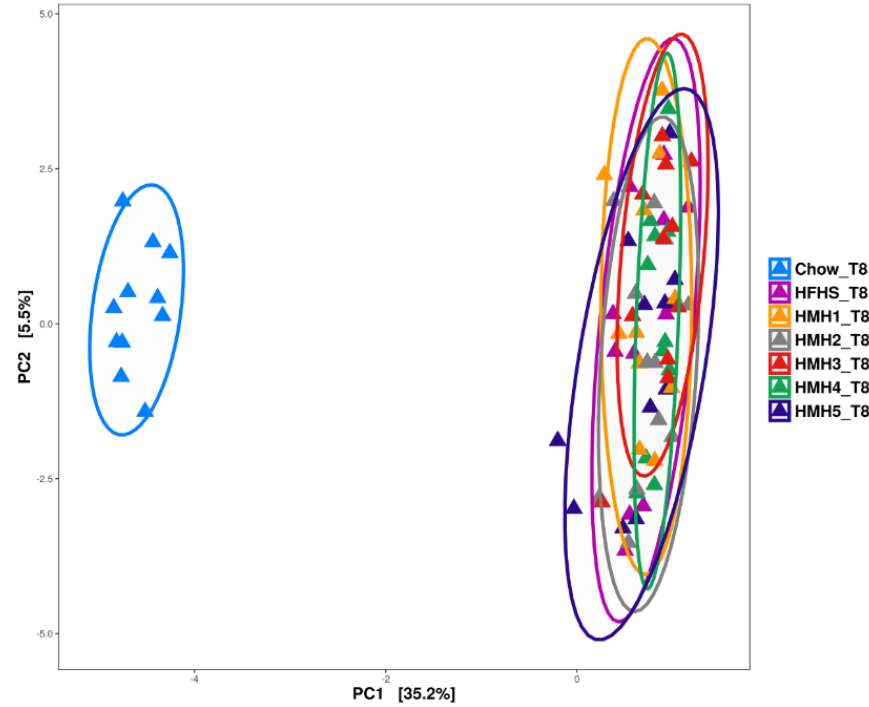
Figure 6. Principal component analysis of fecal samples collected at week 8.